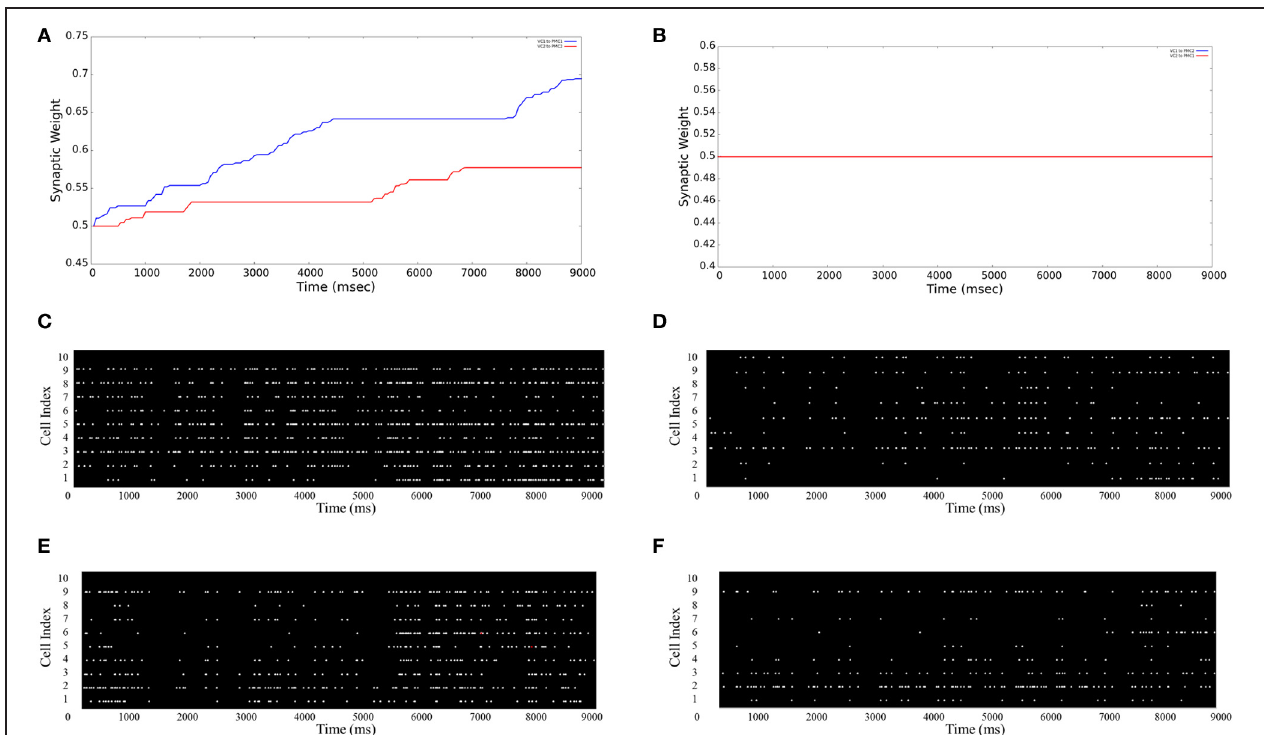
increase in their strengths (note: the blue and red lines are superimposed); ( C and E ) PMC1 and PMC2 firing rates increase as learning occurs—the neurorobot makes correct choices; ( D and F ) PMC1 and PMC2 firing rates do not increase when the neurorobot is not rewarded—makes incorrect